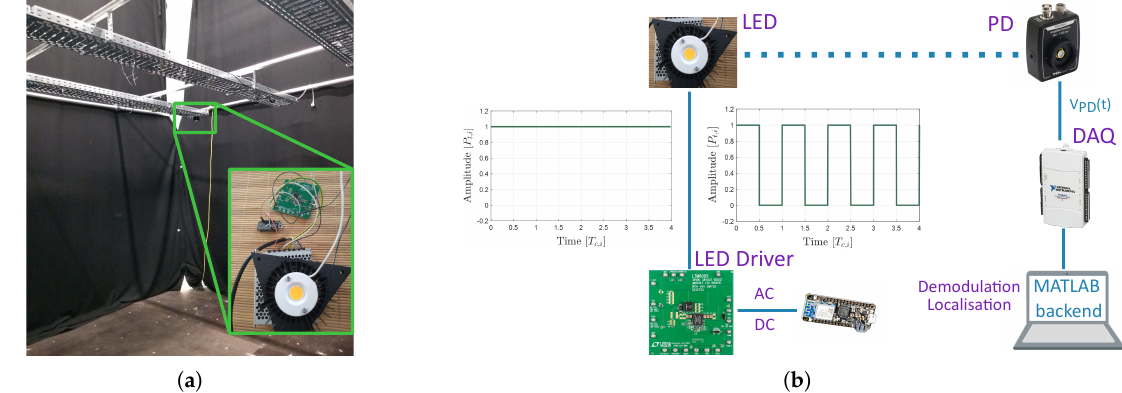
Figure 7. Illustration of the COB (u)VLP (visible light positioning) ( a ) lab setup and ( b ) schematic system